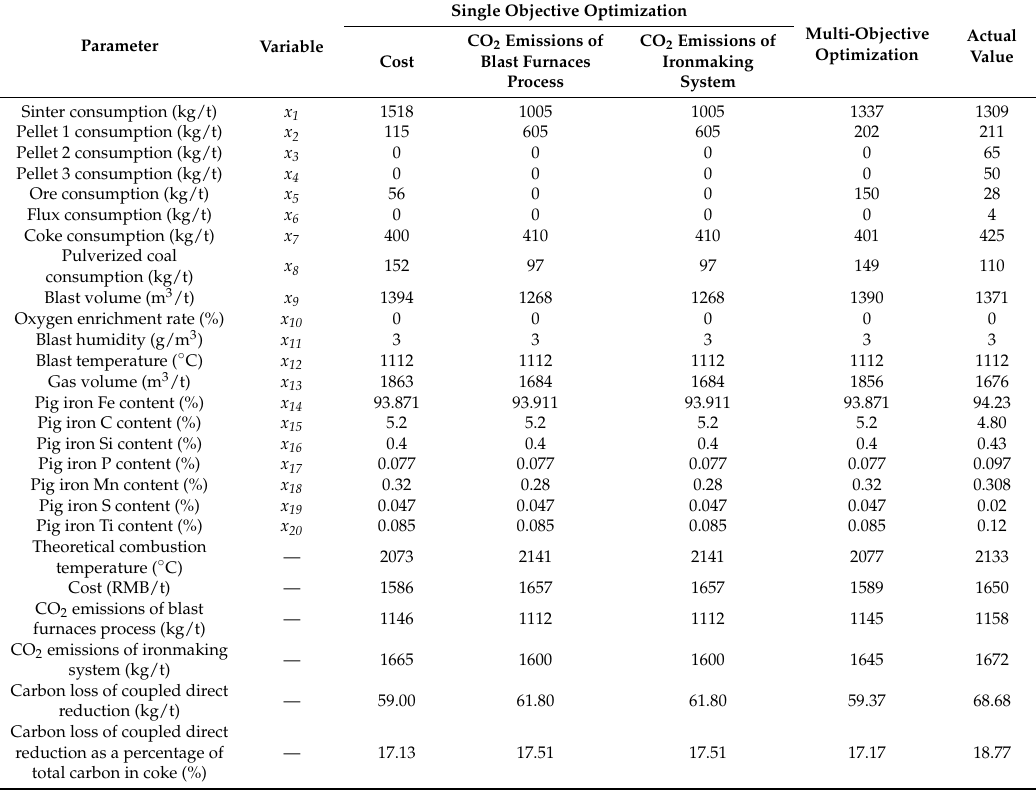
Table 1. Optimization variables and optimum solution of single and multiple objective and actual value of blast